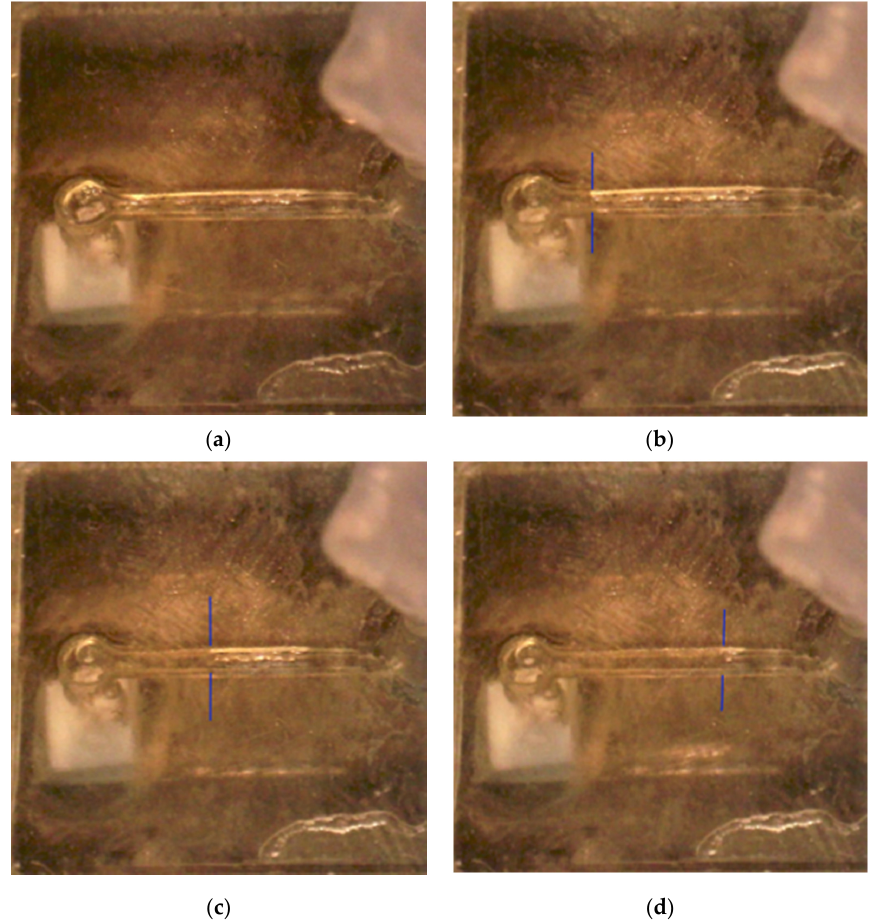
Figure 7. ( a – d ) Images of the garden soil solution extraction process after: ( a ) 0 min; ( b ) 1.5 min; ( c ) 2.5 min; and ( d ) 4.5 min. The position of the water column was barely visible, and is marked with the blue lines. The microfluidic channel was filled after approximately 8 min.